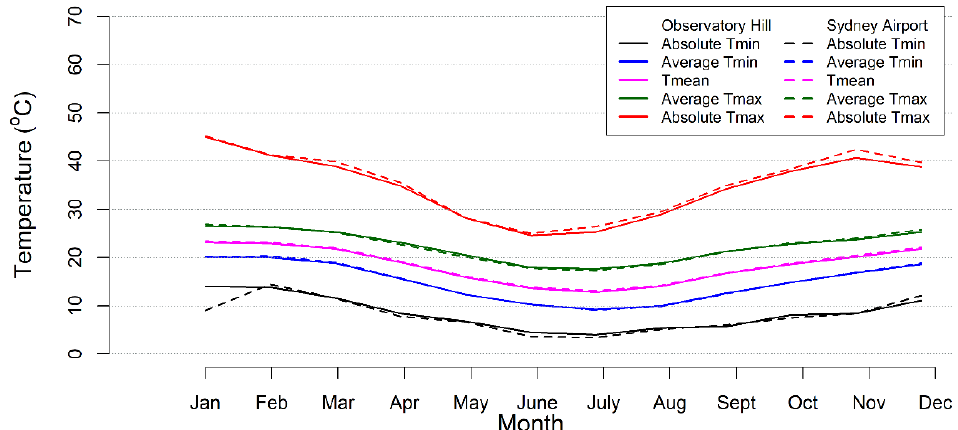
Figure 2. Monthly values of absolute maximum and absolute minimum temperatures, average maximum and minimum temperatures and mean temperatures at the Observatory Hill station (solid lines) and the Sydney airport station (dotted lines).